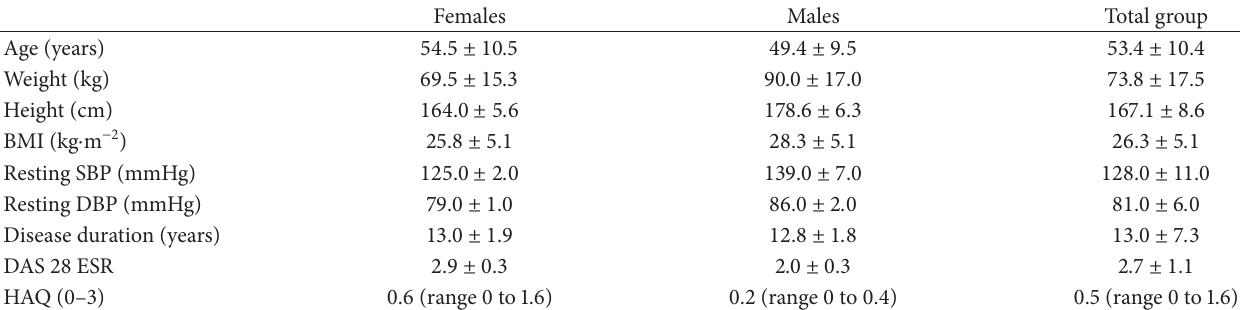
Table 1: Characteristics of 24 patients (19 females and 5 males) with RA participating in the study.